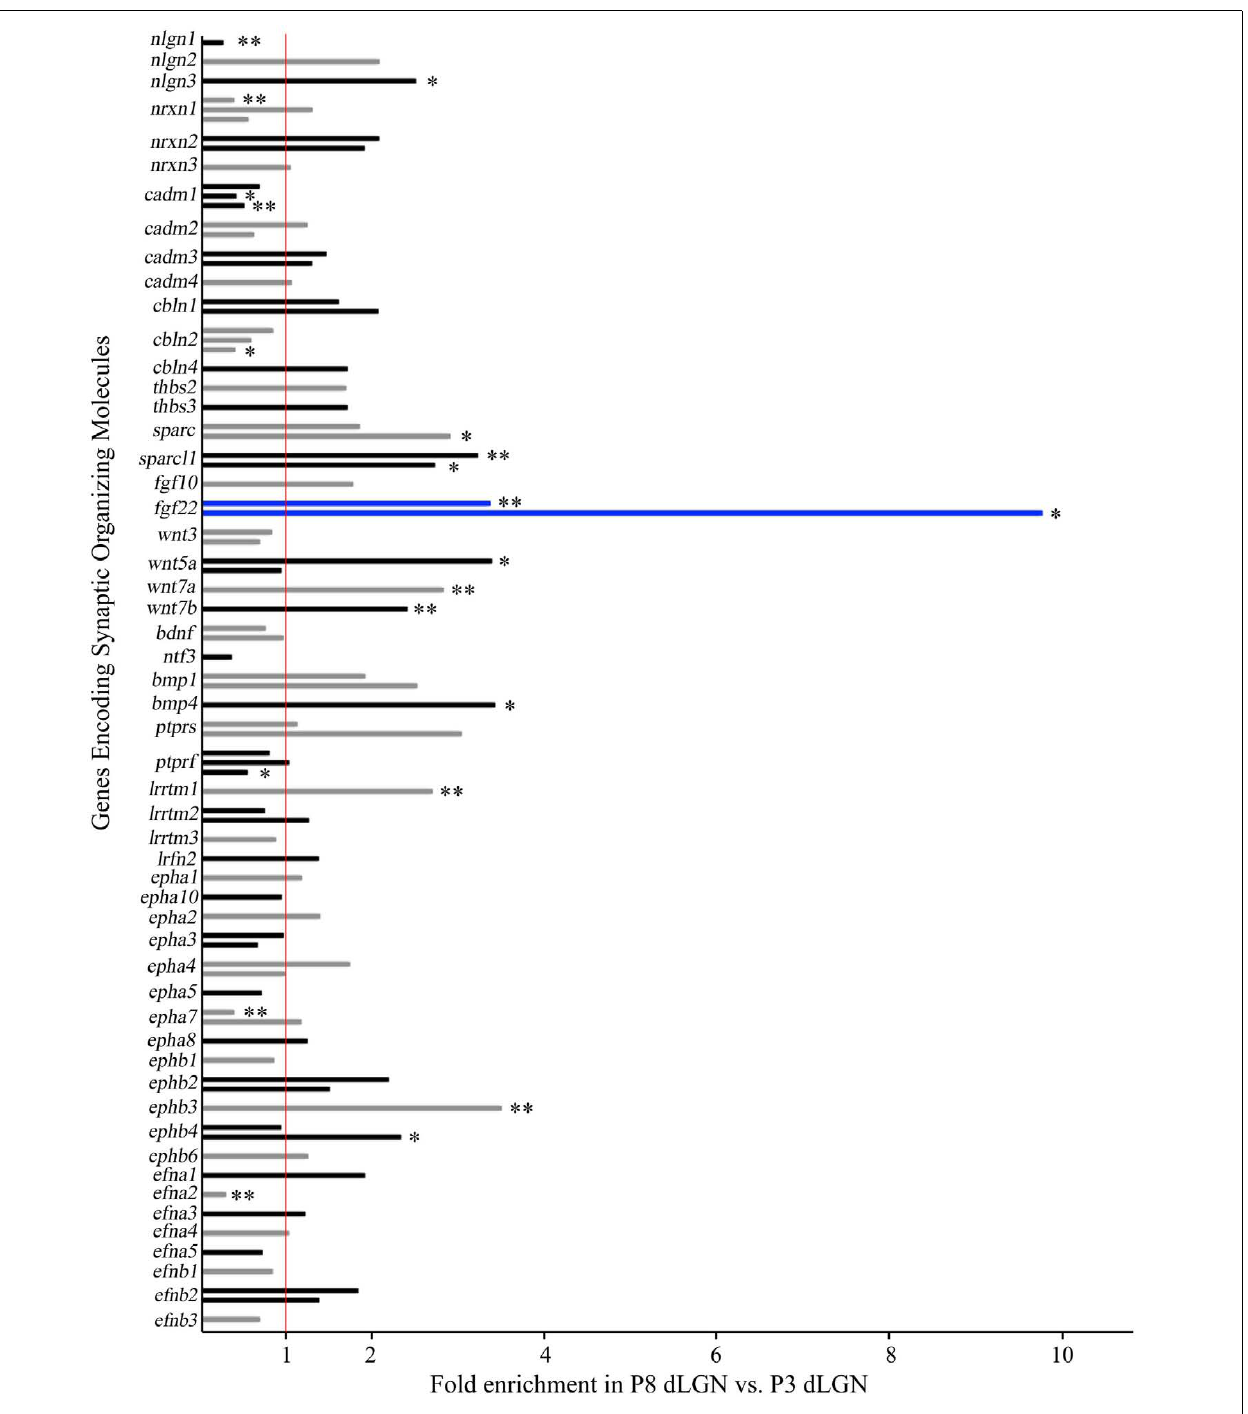
showing the greatest enrichment.The expression of many genes is shown with multiple bars: in these cases each bar represents data from a unique probe set in the array. *Denote data that are statistically significant with p < 0.05. **Denote data that are statistically significant with p < 0.01. Expression of 11 synaptic organizers was enriched in P8 samples ( nlgn3 , sparc , sparcl1 , fgf22 , wnt5a , wnt7a , wnt7b , bmp4 , lrrtm1 , ephb3 , ephb4) whereas seven were significantly down-regulated at P8 ( nlgn1 , nrxn1 , cadm1 , cbln2 , ptprf , epha7 , efna2)